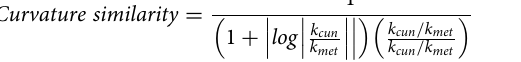
curvature (one concave and one convex surface) and negative one corresponds to equal magnitudes with mis- matched curvature (two concave or two convex surfaces). In a congruent joint, we would expect one concave and one convex surface with similar curvature magnitudes which would be represented by a curvature similarity close to one. A curvature similarity value closer to zero shows a greater difference in magnitude of curvature. Curvature similarity values were calculated for each whole joint and each of the four subregions of the first and second TMT joints. Curvature similarity =